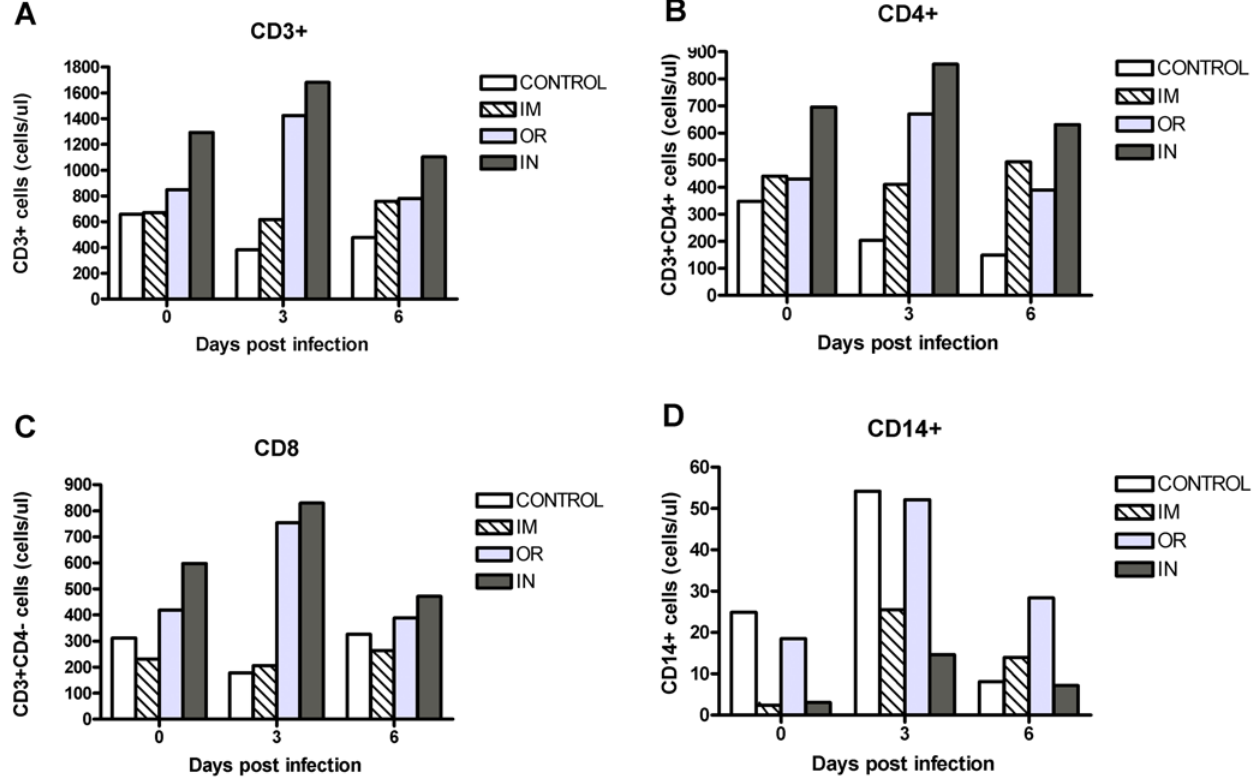
Figure 5. Absolute white blood cell numbers do not decrease in immunized animals after Zaire ebolavirus challenge. Whole blood from cynomolgus macaques immunized either orally (OR; n=4), intranasally (IN; n=4) or intramuscularly (IM; n=2) was stained for lympocytes (CD3 + , CD4 + , CD8 + ), monocytes (CD14 + ). Control animals (n=2) received non protective VSV D G/MARVGP. The absolute numbers in blood was determined for the each of the monkeys by flow cytometry on days 0, 3 and 6 post-challenge with ZEBOV. The average for each inoculation route is represented. doi:10.1371/journal.pone.0005547.g005 PLoS ONE |